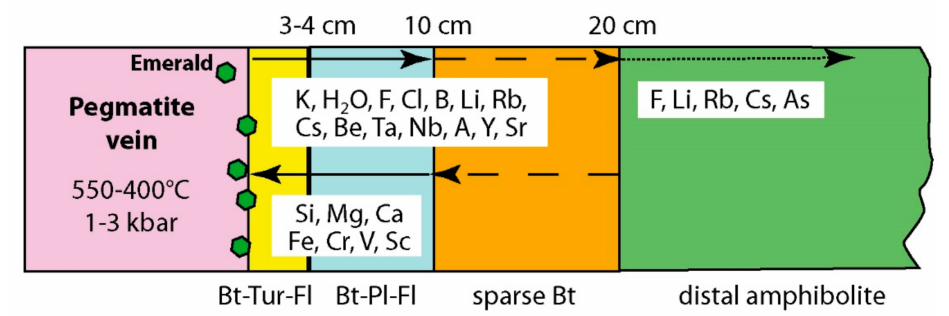
Figure 37. The Khaltaro emerald deposit, Nanga Parbat—Haramosh massif, Pakistan [83]. A symmetrically zoned metasomatic column is formed at the contact of the albitized pegmatites or hydrothermal quartz veins with amphibolite. The mass balance calculation in the metasomatized amphibolite indicates the gains and losses of components (see the transferts in the outer and inner zones). Emerald froms within the vein, near the contact with the altered